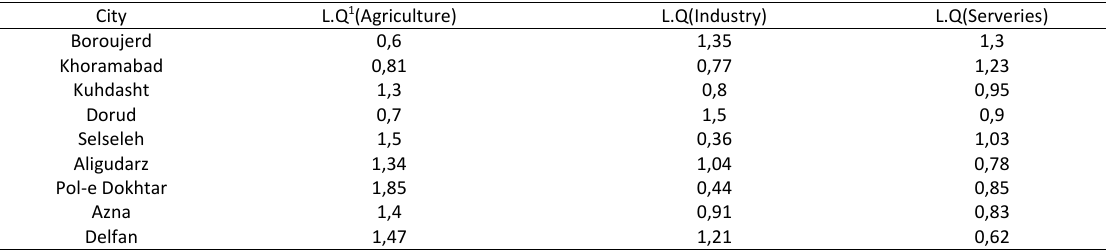
Table 1: Comparison of the spatial coefficient of Boroujerd city with other cities of Lorestan province, (Statistical yearbook of Lorestan province, 2011) City L.Q 1 (Agriculture)